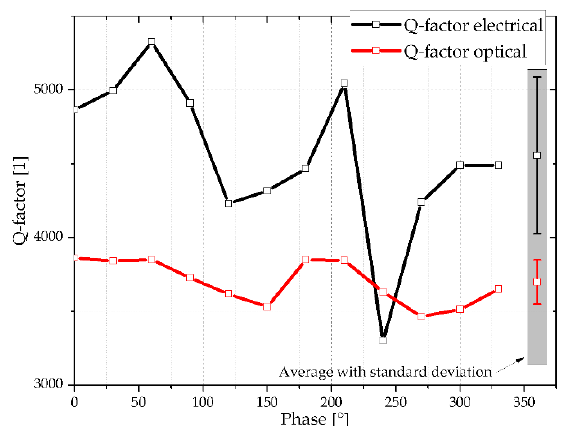
Figure 8. Q-factor characteristics determined either electrically or optically as a function of phase shift between cantilever actuation and shaker. The inserted lines serve as guide to the eyes.